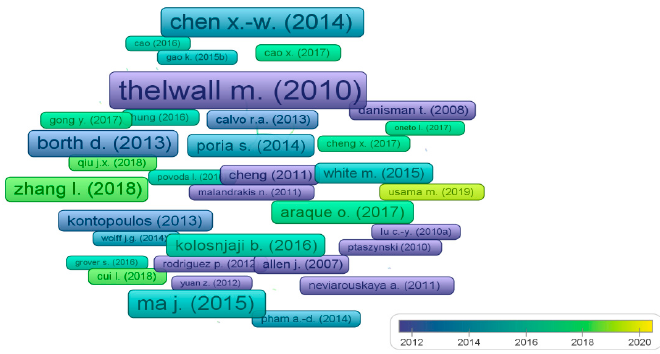
Figure 18. Citation document correlation using a network graph.